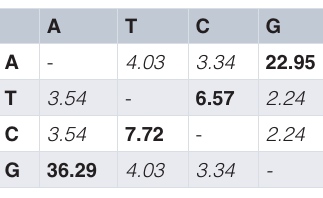
Table 1. Maximum composite likelihood estimates of the pattern of nucleotida substitution.